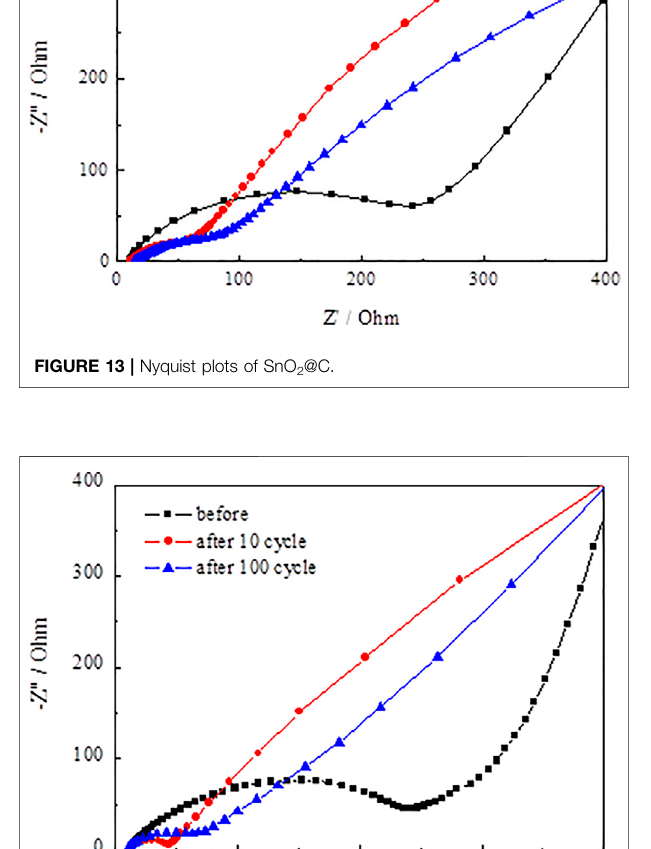
2 @C and SnO 2 @C/graphene